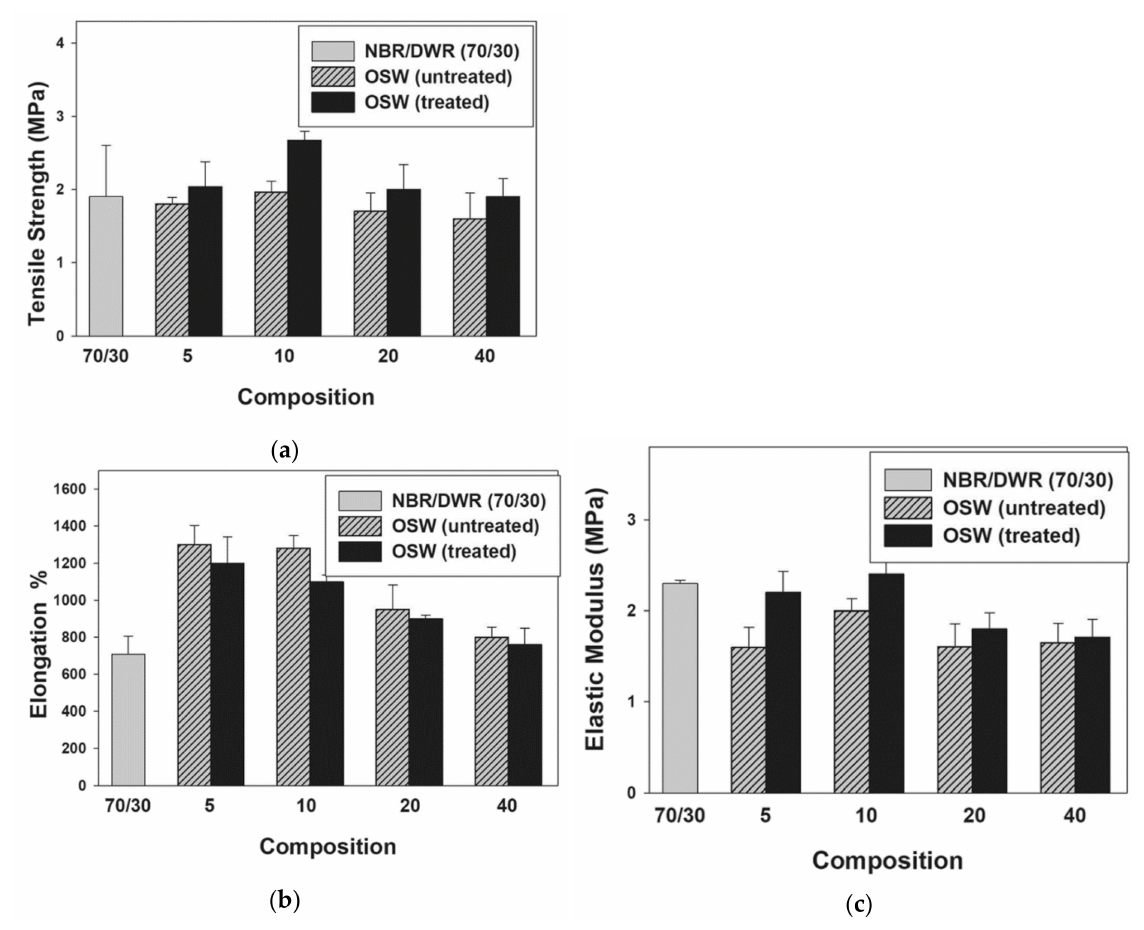
Figure 14. Tensile properties of acrylonitrile butadiene rubber/devulcanized waste rubber (NBR/DWR) blend (70/30) reinforced with different concentrations of (treated or untreated) olive stones waste; ( a ) Tensile Strength (TS), ( b ) Elongation at break % (Eb), ( c ) Elastic Modulus (EM)